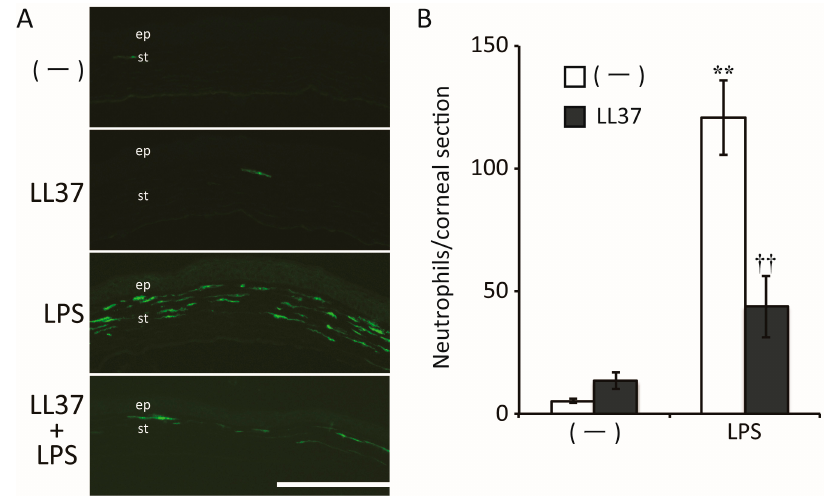
Figure 6. Effects of LL37 in a mouse model of LPS-induced keratitis. ( A ) The cornea was scratched and either LL37, LPS, both LPS and LL37, or phosphate-buffered saline (PBS) vehicle was applied. After 24 h, the eye was enucleated for immunohistofluorescence staining of neutrophils in the cornea. The corneal epithelium (ep) and stroma (st) are indicated. Scale bar, 200 µm; ( B ) the number of infiltrating neutrophils in the corneal stroma in images similar to those in ( A ) was counted. Data are means ± SEM for one section examined for each of four eyes. ** p < 0.01 versus the value for PBS alone; †† p < 0.01 versus the value for LPS alone. Reprinted with permission from [56].